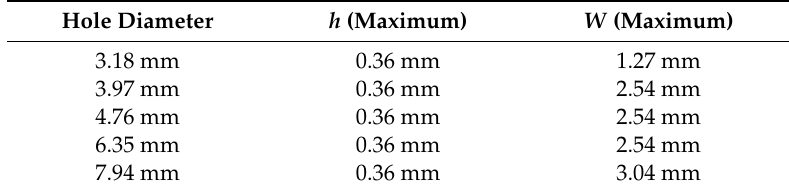
Figure 5. Defect range for hole-making in carbon fiber-reinforced plastic (CFRP). Table 2. Defect criteria for hole-making in CFRP.